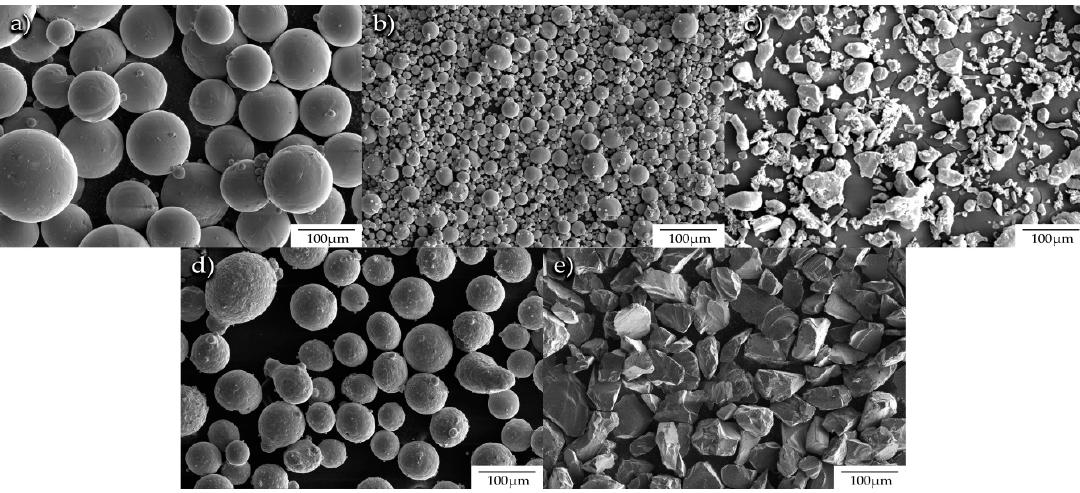
Figure 1. Scanning Electron Microscope (SEM) images of the raw powders: ( a ) spherical titanium matrix powder morphology; ( b ) fine titanium; ( c ) aluminium particles; ( d ) prealloyed TiAl powder; ( e ) faceted B 4 C particles.